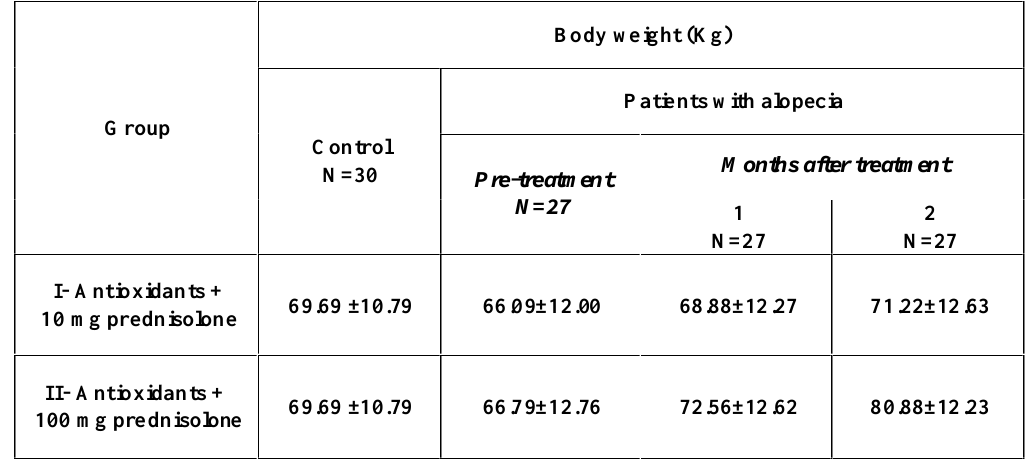
Table (5): body weight of control and age matched alopecic patients..